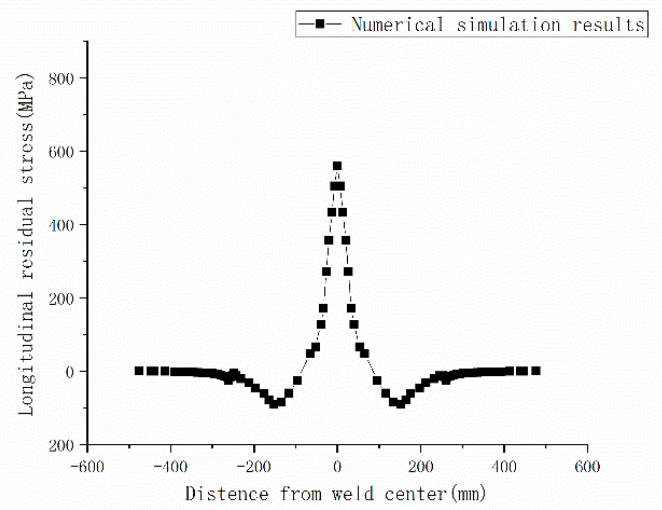
Figure 17. Longitudinal residual stress along the vertical weld path on the outer surface of the spherical pressure hull.